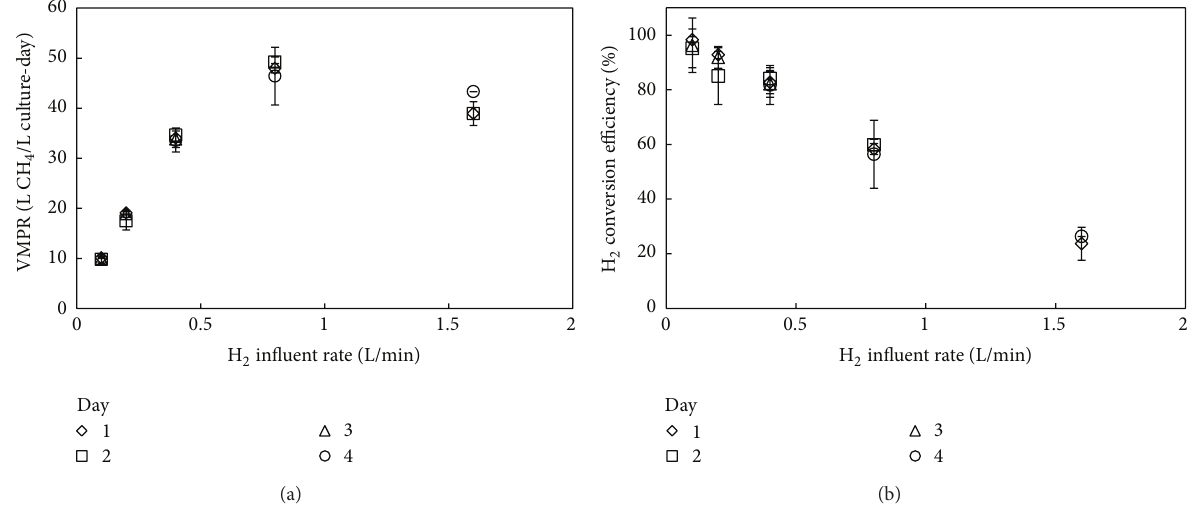
Figure 2: Bioreactor performance for Experiment 1. Volumetric methane production rates (a) and hydrogen conversion efficiencies (b) for bioreactor runs in which the hydrogen influent rate was varied. Data were gathered during four days. The error bars represent the observed variance between runs for each bioreactor condition within one day of experimentation.